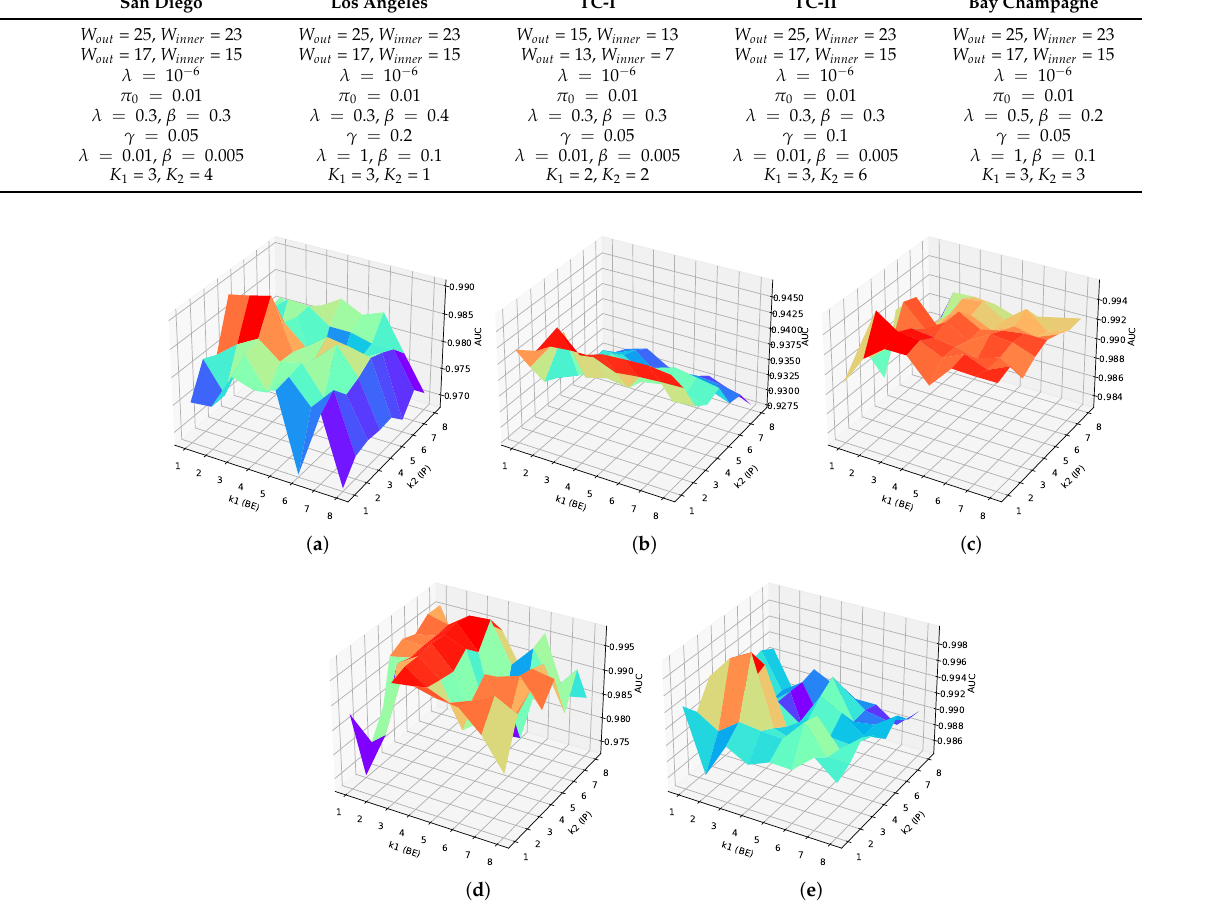
Figure 12. The AUC value varies with parameters of K1 and K2. ( a ) San Diego data set. ( b ) Los Angeles data set. ( c ) TC data set-I. ( d ) TC data set-II. ( e ) Bay Champagne data